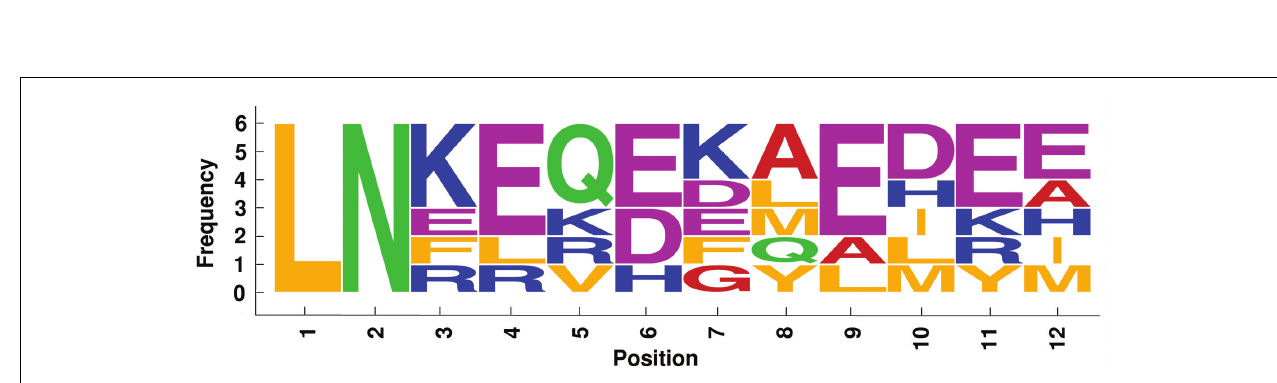
FIGURE 6 | Sequence logo of mapped residues in the best alignment of the 8 Flavodoxin-like fold CheY-related proteins.